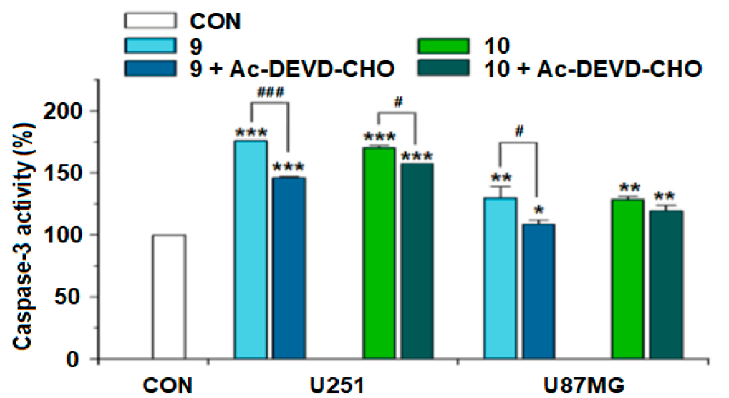
Figure 8. Effect of questiomycin A ( 9 ) and xanthocillin X ( 10 ) on the MMP in glioma U251 and U87MG cells. Glioma U251 and U87MG cells were treated with 9 (20 µM), 10 (20 µM), and BTZ (16 µM) at different time points. Data are presented as the mean ± SD, n = 4; * p < 0.05, ** p < 0.01 or *** p < 0.001 (vs. CON).